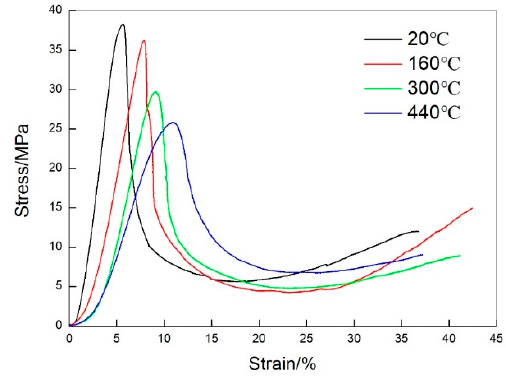
Figure 6. Flatwise compressive stress versus strain curves of the unvented honeycomb sandwich panels. Table 4. Flatwise compression properties of the unvented honeycomb sandwich panels.